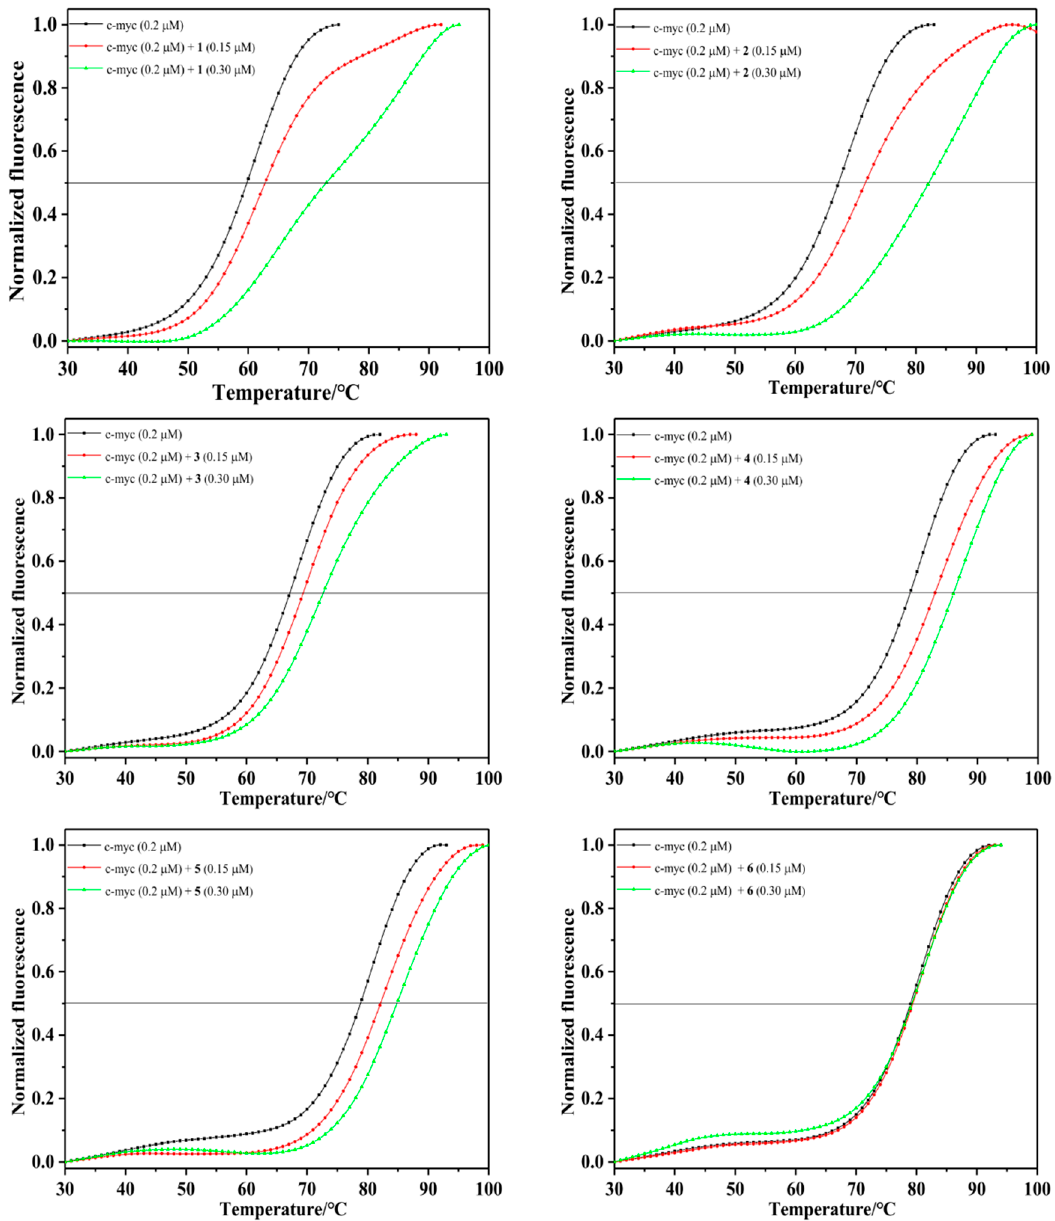
Figure 5. Normalized FRET melting curves of c-myc G-quadruplex DNA (0.2 μ M) in a K + buffer, with increasing concentrations (0–0.3 μ M) of Ru(II) complexes ( 1 – 6 ) measured by real-time polymerase chain reaction PCR system.